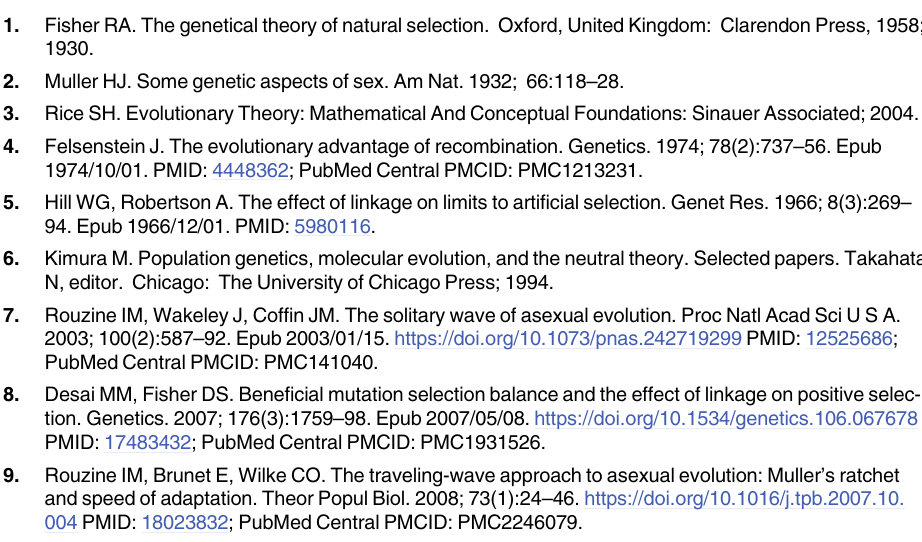
S2 Fig. Dependence of 5 different types of linkage measure (S1B–S1F Fig) on epistatic strength predicted for square topology.